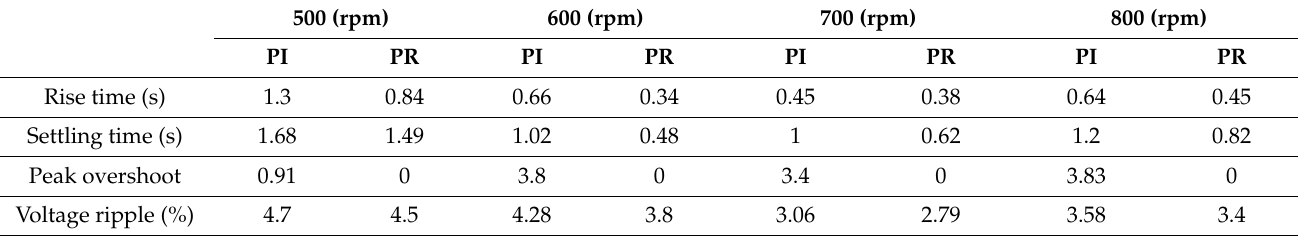
Table 5. Controllers’ performance for wind speed change operation.